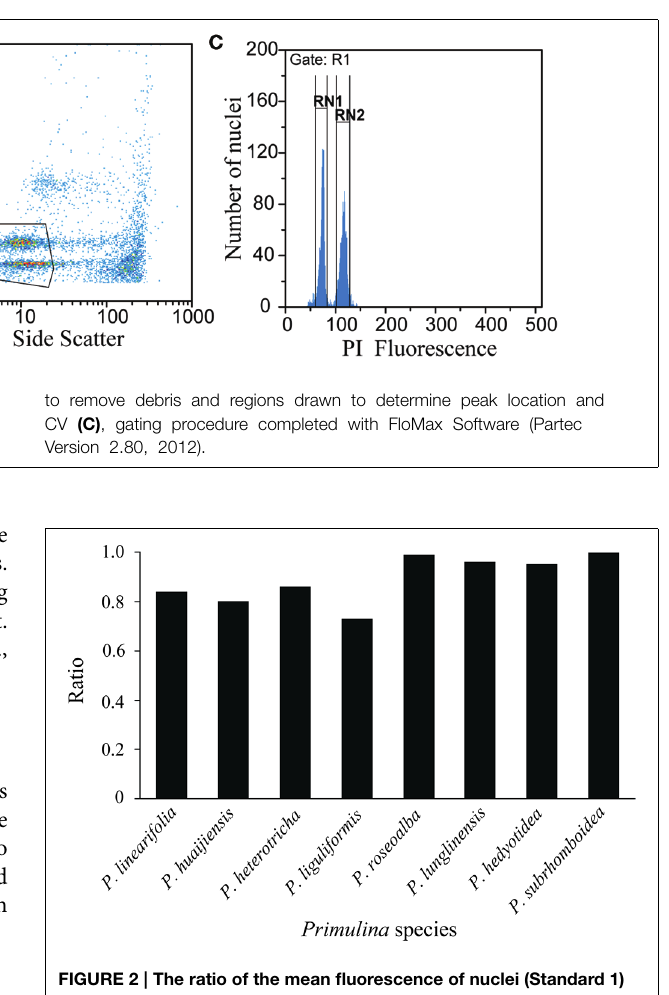
FIGURE 2 | The ratio of the mean fluorescence of nuclei (Standard 1) from simultaneously processed standard ( Solanum lycopersicum or Oryza sativa ssp. japonica ) with Primulina leaves to the mean fluorescence of nuclei (Standard 2) from an independently processed standard using the Partec CyStain PI Absolute P